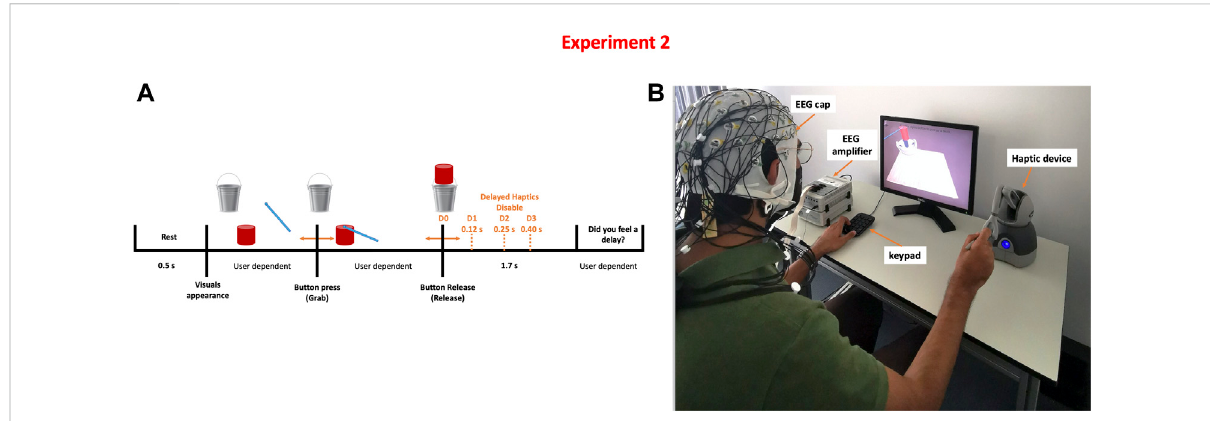
FIGURE 2 Detecting the level of haptic delay experiment (A) Task time-line of a single trial where four possible delay levels can be perceived (B) Experimental setup showing a participant correctly holding the stylus to pick up and carry the